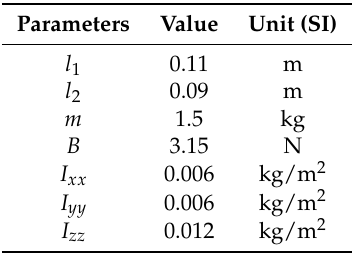
Figure 4. Testbed in the water tank. Table 1. Mechanical parameters of the